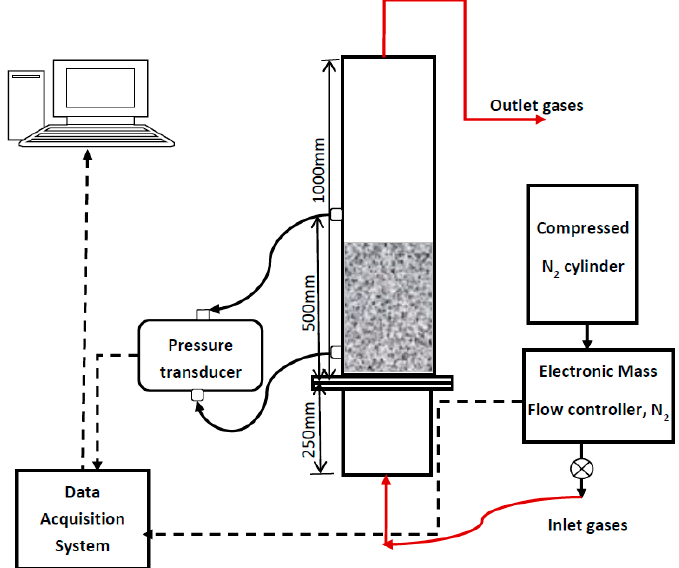
Figure 1. Schematic of the experimental setup used for fluidization at ambient conditions using compressed nitrogen as the fluidizing gas (broken lines represent data communication lines).